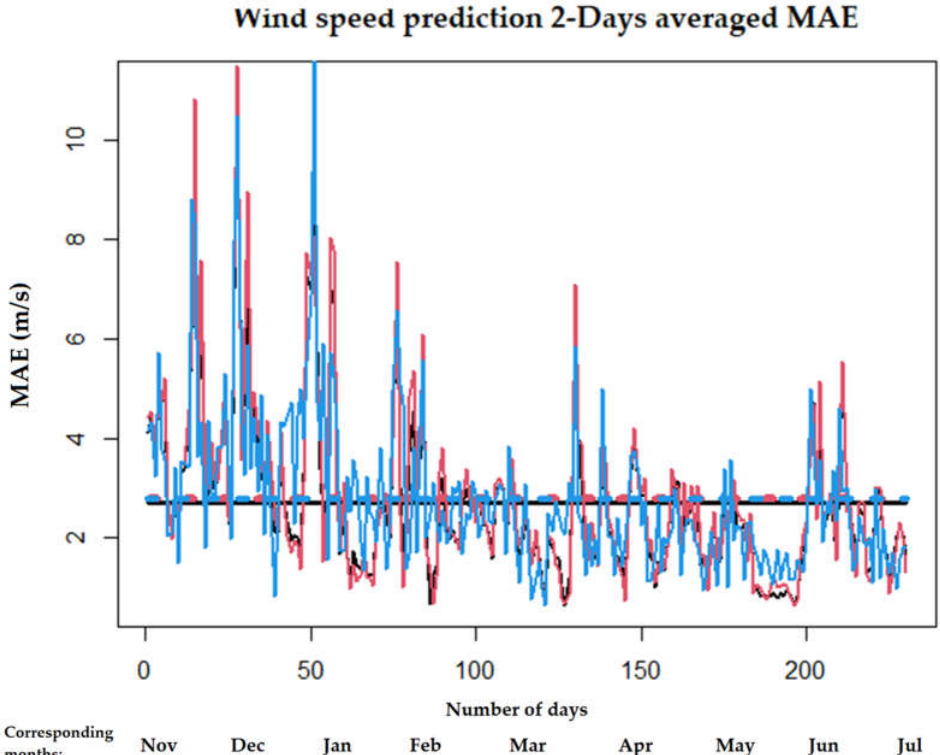
Figure 11. Comparison of SARIMA, LSTM and hybrid using daily averaged MAE with real data for 2-day prediction horizon on wind speed prediction for 230 days of the test set. With dashed lines the average error of all the dataset is shown. Units of MAE are in m/s in this wind speed example.